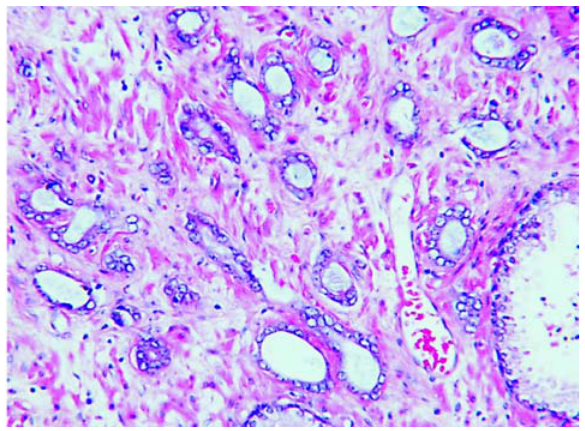
Figure 3 – Infiltrating acinar structures composed of uniform cuboidal cells with prominent nucleoli, morphologically consistent with prostatic acinar adenocarcinoma (HE,